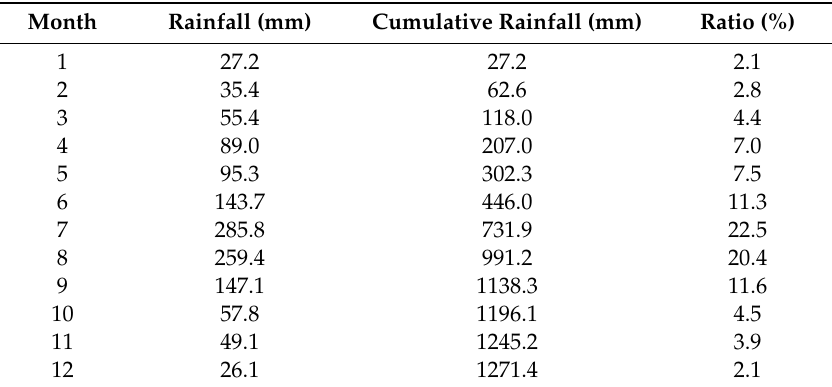
Table 3. Average monthly rainfall trends (1965 – 2018).